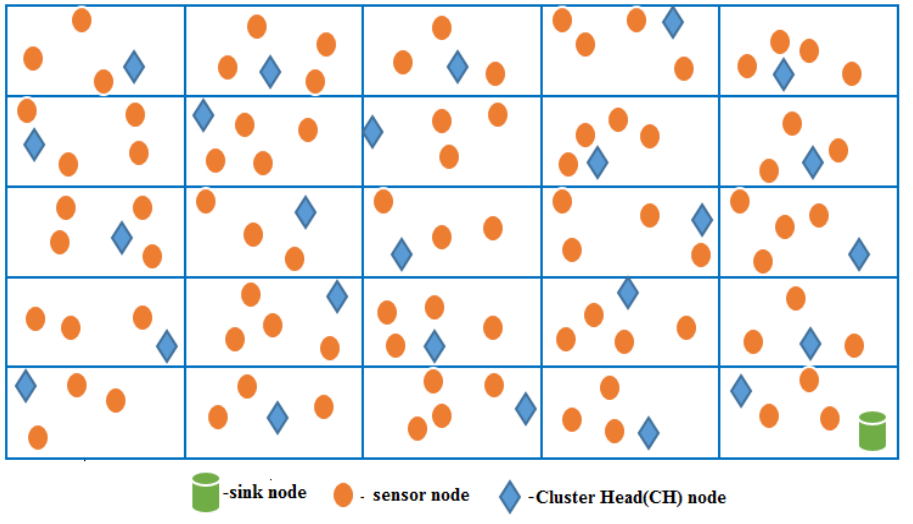
Figure 2. Node deployment based on the grid method.